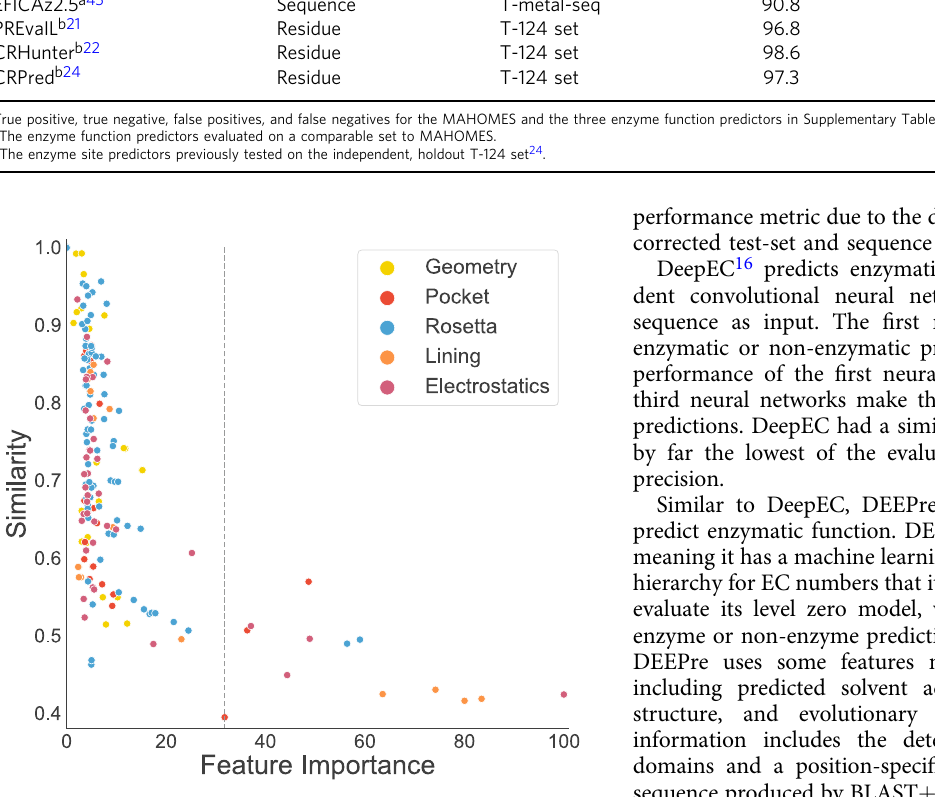
(Table 1); DeepEC 16 , DEEPre 17,44 , and EFICAz2.5 45 . MCC is